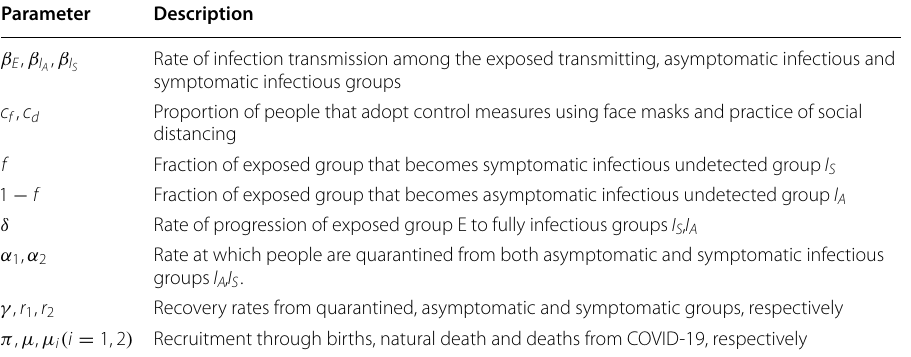
Table 2 Parameters for model (1) and their descriptions Parameter